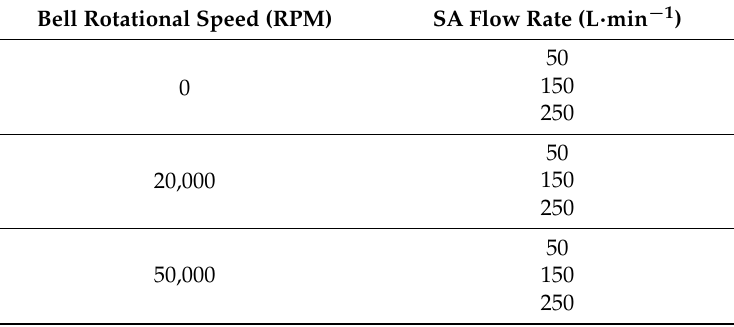
Table 1. SA visualization operating conditions.